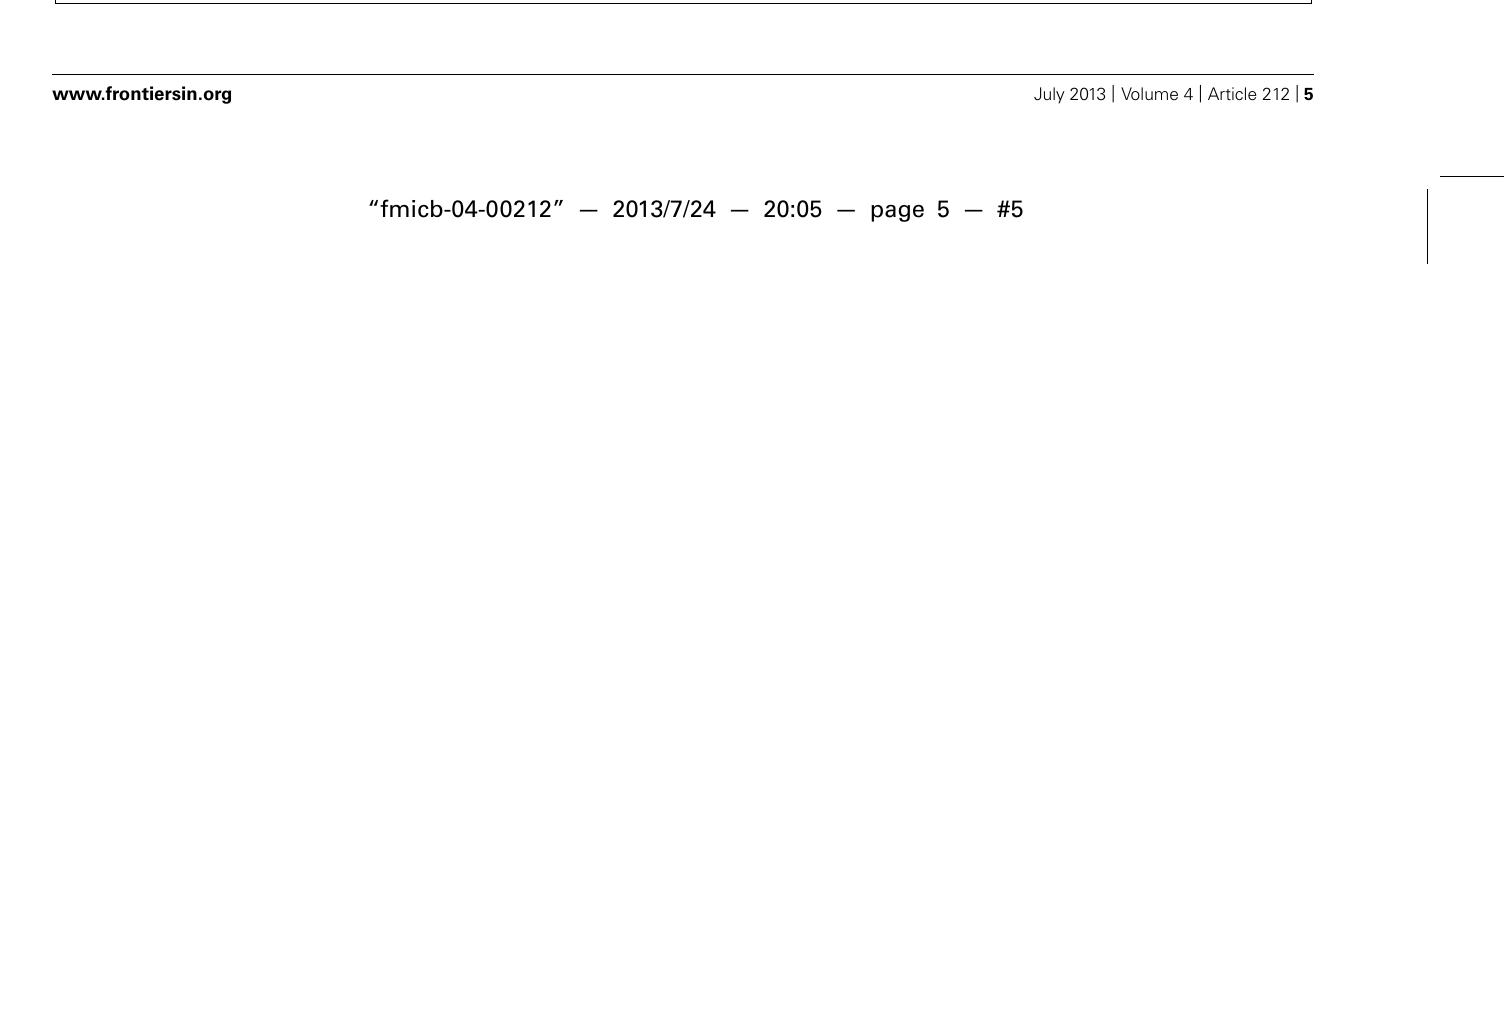
FIGURE 1 | Currently explored approaches aiming at developing new animal models for the study of hepatitis C virus infection. From left to right: xenotransplantation of human cells, genetic humanization by expression